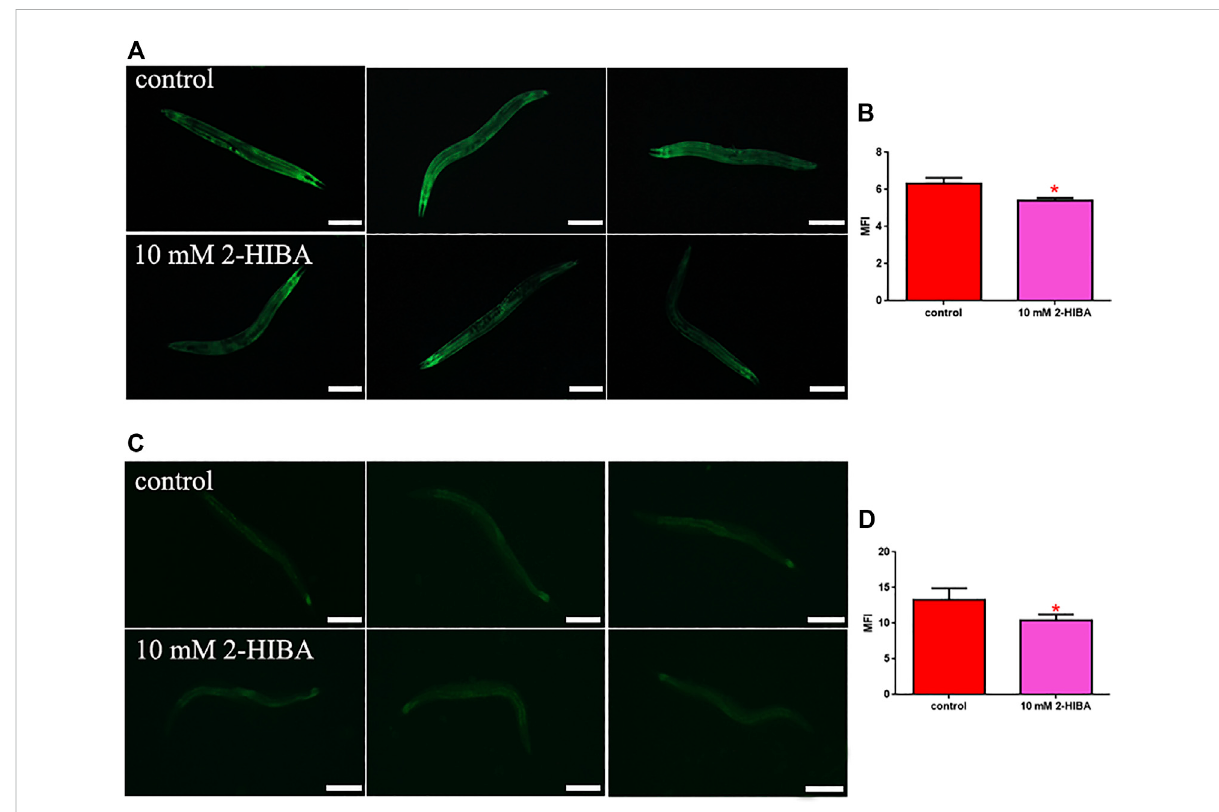
FIGURE 4 Fluorescence microscopy of gst-4 ::GFP and sod-3 ::GFP transgenic strains. (A) Fluorescence microscopy of gst-4 ::GFP worm strain after supplementation of10 mM 2-HIBA and (B) related MFI. (C) Fluorescencemicroscopy of sod-3 ::GFP worm strain after supplementation of10 mM 2- HIBA and (D) related MFI. Scale bar = 100 μ m control: untreated worms. Statistical analysis was evaluated by one-way ANOVA with the Bonferroni post-test; asterisks indicate signi fi cant differences (* p < 0.05). Bars represent the mean of three independent